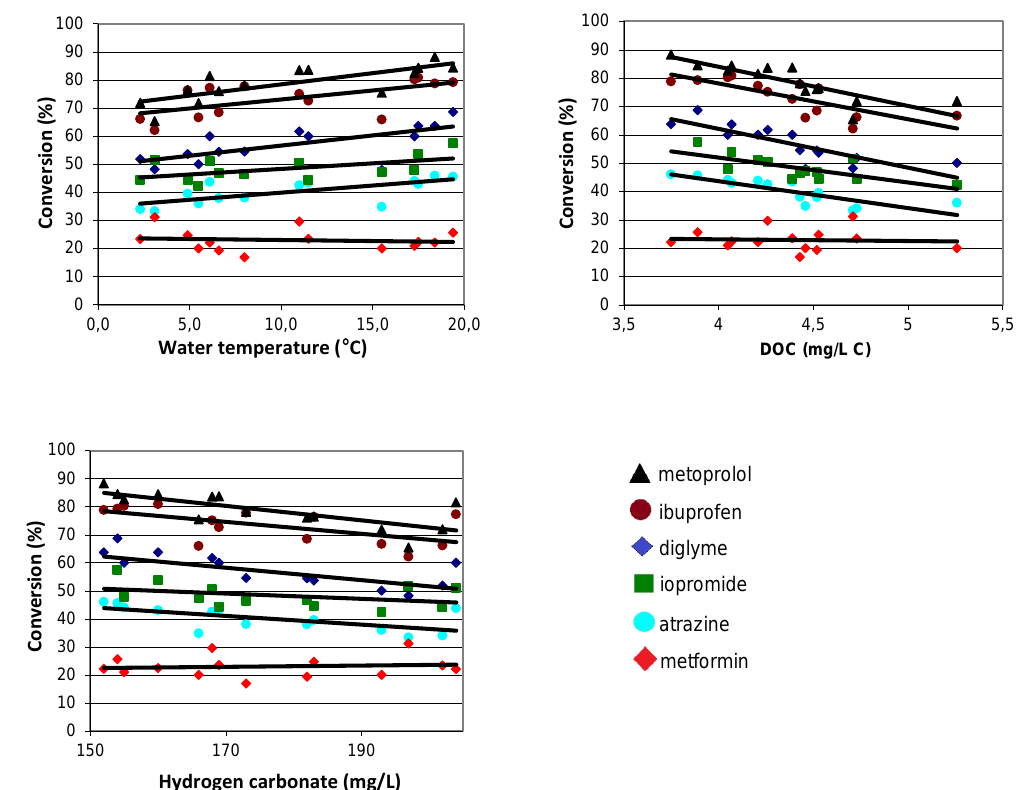
Figure 10. Conversion of compounds versus water temperature and DOC and bicarbonate concentration.